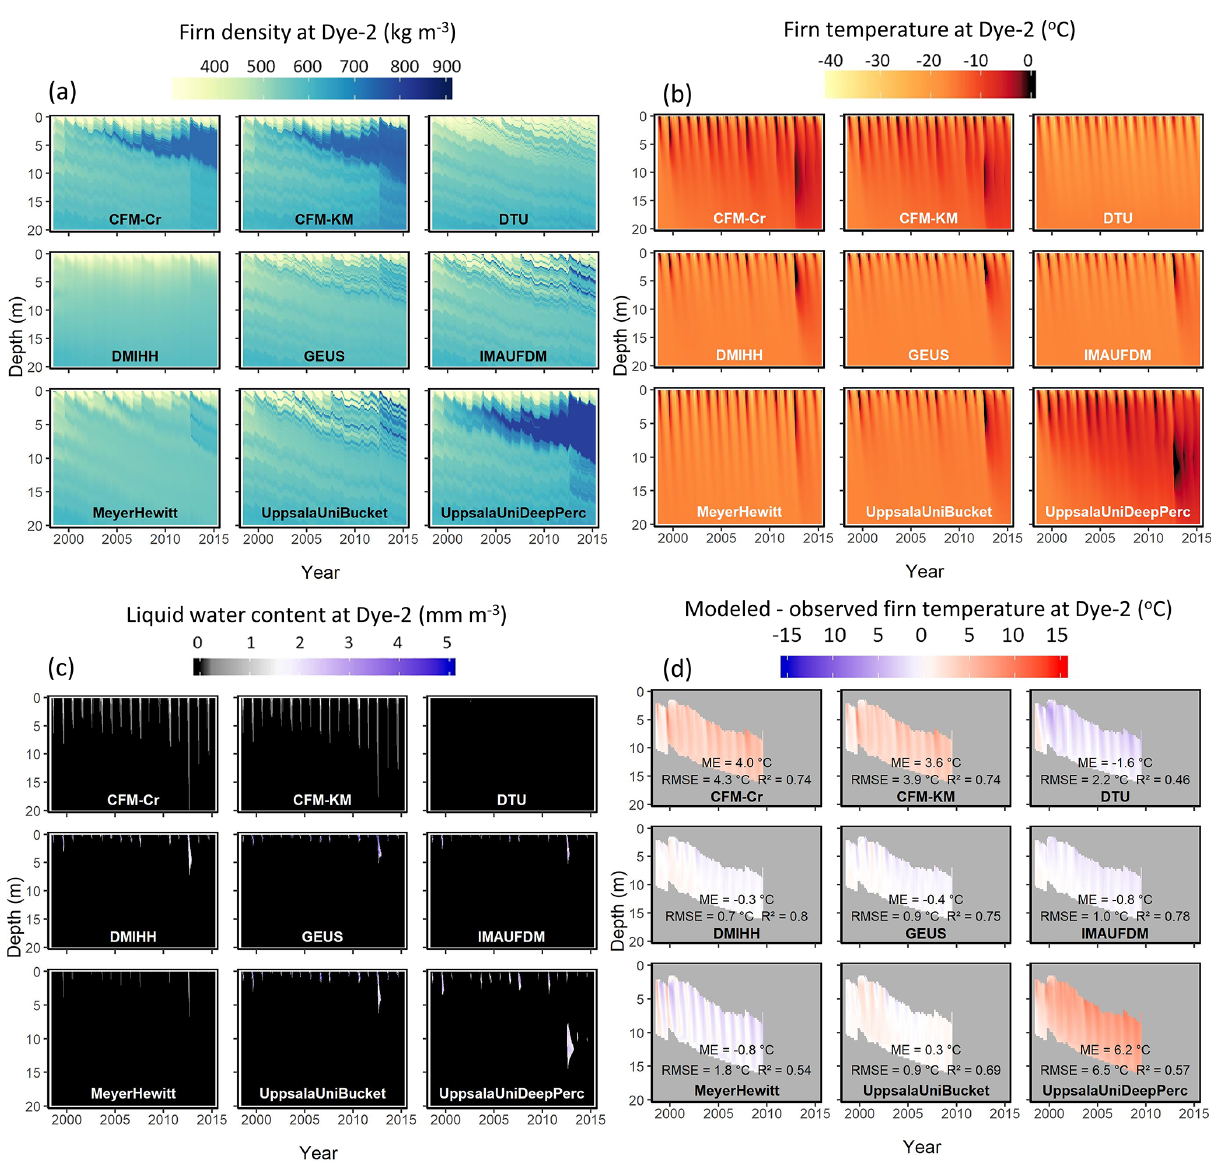
Figure 4. Simulated firn density (a) , temperature (b) , water content (c) and deviation between simulated and observed firn temperature (d) at